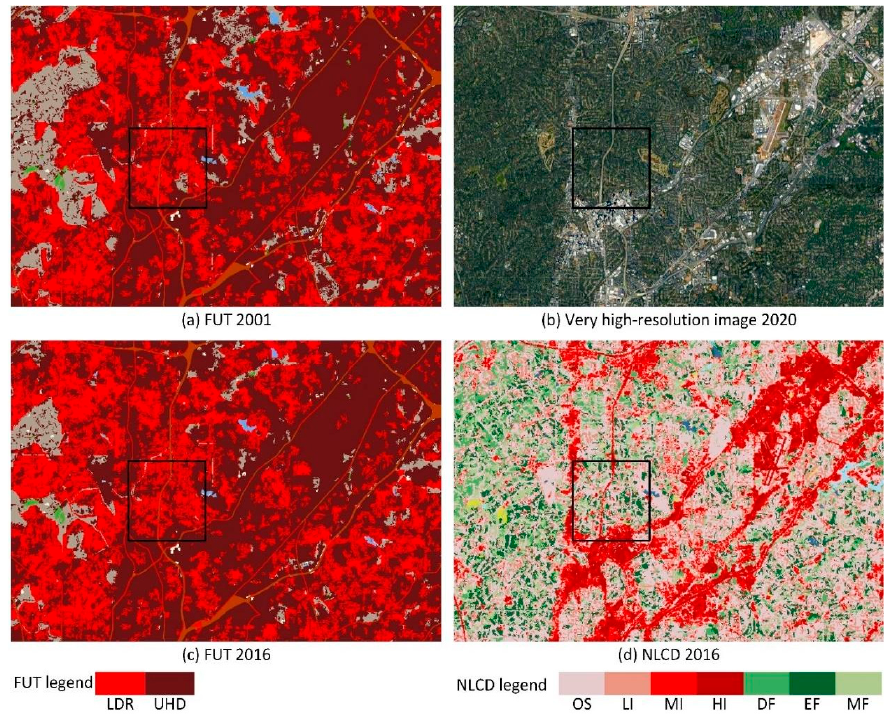
Figure 4. Residential forestlands northeast of Atlanta (highlighted in black rectangle, primarily classified as LDR in FUT layers) that maintain a stable classification of LDR over time, resisting conversion to UHD, as reflected by comparison between FUT 2001 ( a ) and 2016 ( c ). ( b ) A very high-resolution image for the year 2020 showing residential vegetation remains intact from urbanization. ( d )